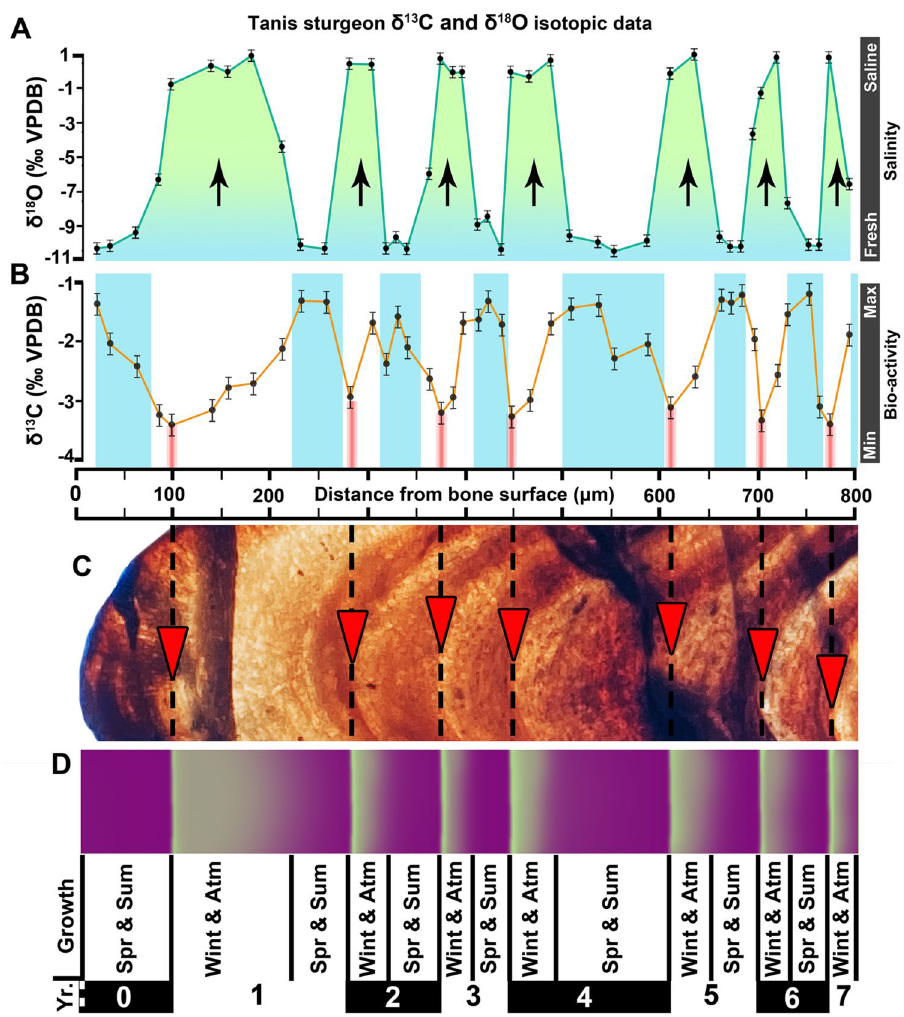
Figure 2. Bone growth patterns reflected in isotopic and histological data. ( A ) δ 18 O data from a sturgeon pectoral fin spike (FAU.DGS.ND.755.57.T) shows a repeated fluctuation between saline (arrows) and freshwater living conditions. The freshwater zones of bone growth correlate with peak times in biological productivity (blue bands in [ B ]), while the saline zones correlate with lowest productivity that are histologically consistent with winter months 13,24–26 . ( B ) δ 18 C values for incremental samples from the same thick section, taken 1 mm adjacent to the samples in ( A ), showing multi-year fluctuations that inversely relate to the oxygen data. ( C ) a photomicrograph of the same fin spike, showing fluctuations in annual growth history that correlate with the isotopic data. Red arrows point to annual lines of arrested growth (LAGs) deposited during winter. ( D ) an idealized schematic of the histological patterns in ( C ), with subdivisions of growth bands labelled according to their season of growth 13,24–26